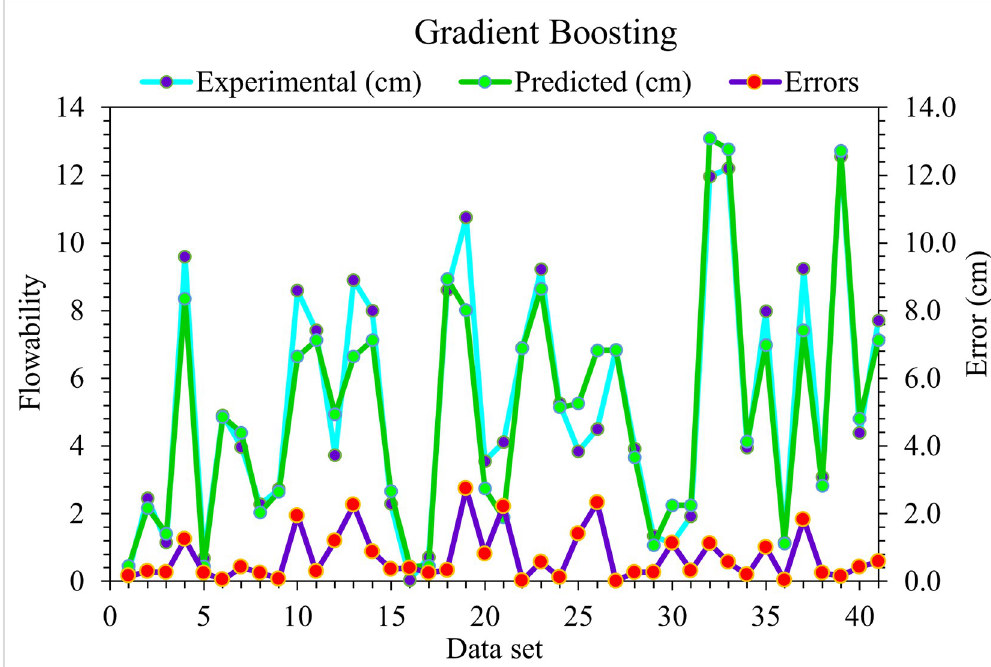
Fig 9. GB predicted and experimental error values—UHPC flowability.